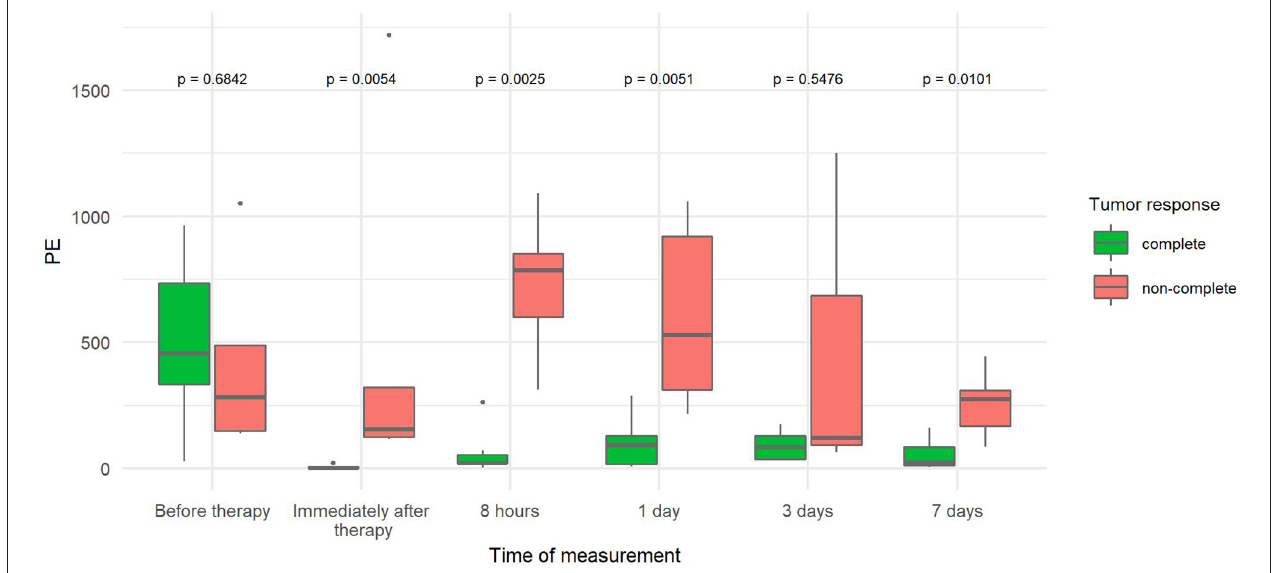
FIGURE 3 | Comparison of peak enhancement (PE) at different time points between canine tumors with complete (CR) and non-complete (non-CR) responses to combined electrochemotherapy treatment with gene electrotransfer of plasmid DNA encoding interleukin IL-12 (ECT GET pIL-12). Note the p -values presented at the top of the image. Note that PE is significantly lower for complete response tumors than for non-complete response tumors at all time points after therapy except at 3 days.